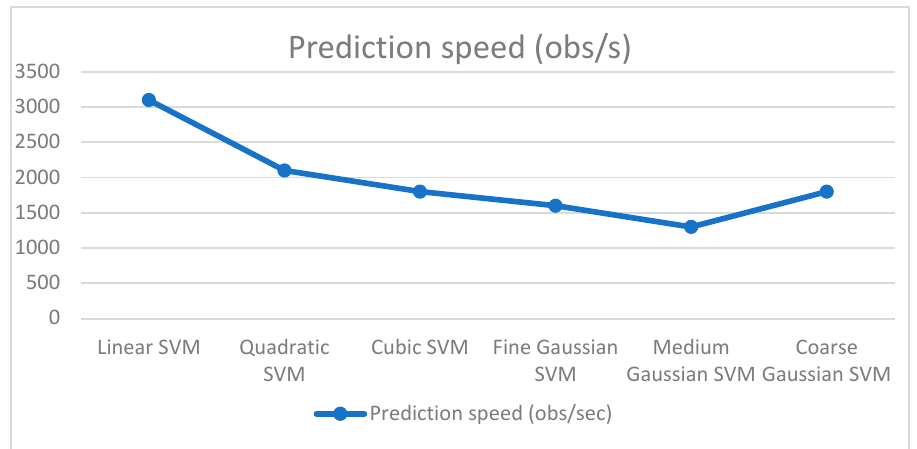
Figure 7. Prediction speed of 250 features.